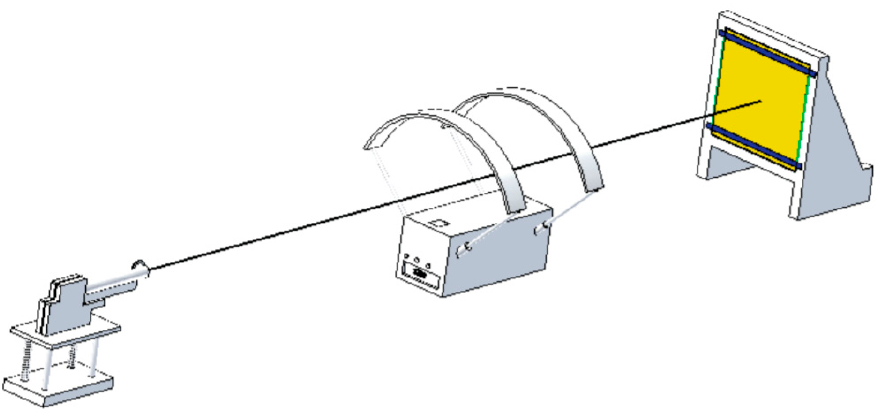
Figure 1. Ballistic test set up. (Adapted with copyright permission from Karahan (Cai, Z., et al. 2016)).